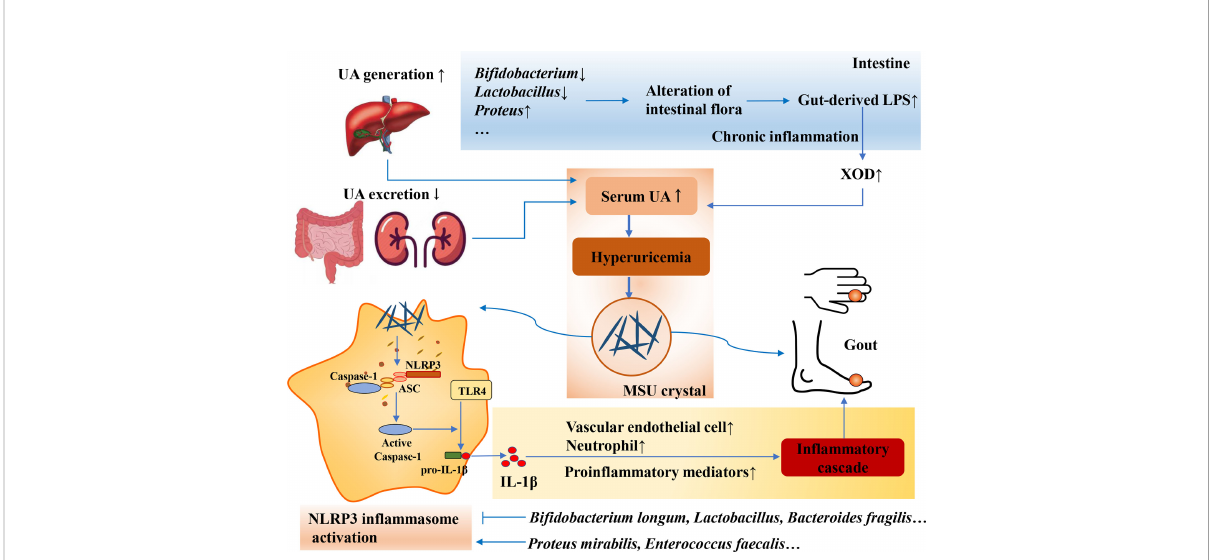
FIGURE 4 Intestinal fl ora affects the secretion of LPS and in fl ammatory response. Loss of gut barrier resulting from gut dysbiosis leads to gut-derived LPS translocation and chronic in fl ammation, resulting in the increase of SOD activity and serum UA. Moreover, gut microbiota can also modulate NLRP3 in fl ammasome activation, and the commensal microbiota shapes the ability of the host to respond to acute in fl ammatory stimuli that are dependent on the extra-intestinal in fl